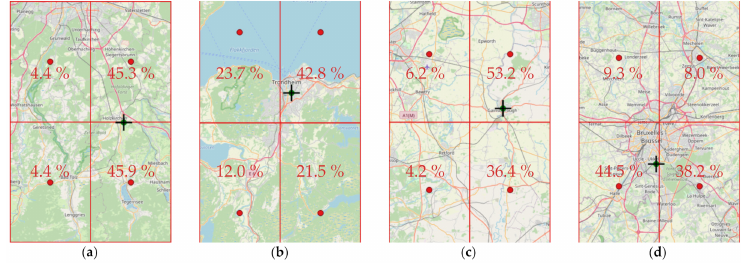
Figure 3. Locations of cases ( a ) Holzkirchen DE, ( b ) Trondheim NO, ( c ) Gainsborough UK, and ( d ) Brussels BE, and nearest ERA5 grid cells (red lines) overlaid over local area maps. The percentages illustrate the resulting bilinear weighting of the adjacent cells. Map data from